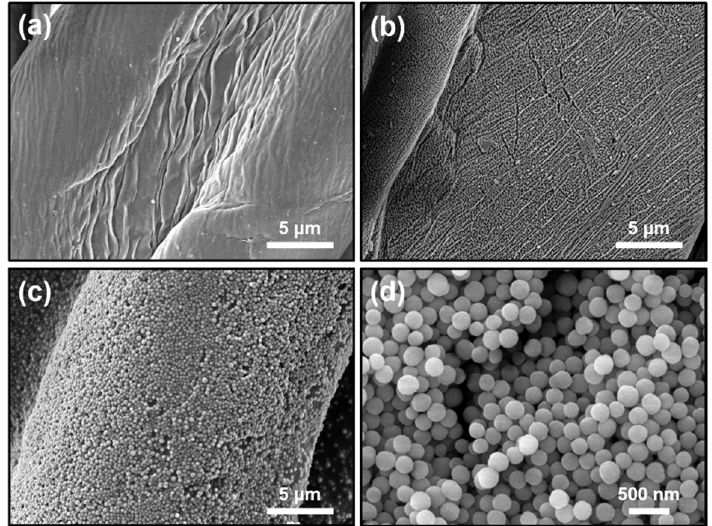
Figure 2. SEM images of ( a ) raw cotton, ( b ) Ar plasma-treated cotton, ( c ) OmniBlock-coated cotton fabric, and ( d ) Si NPs as prepared.